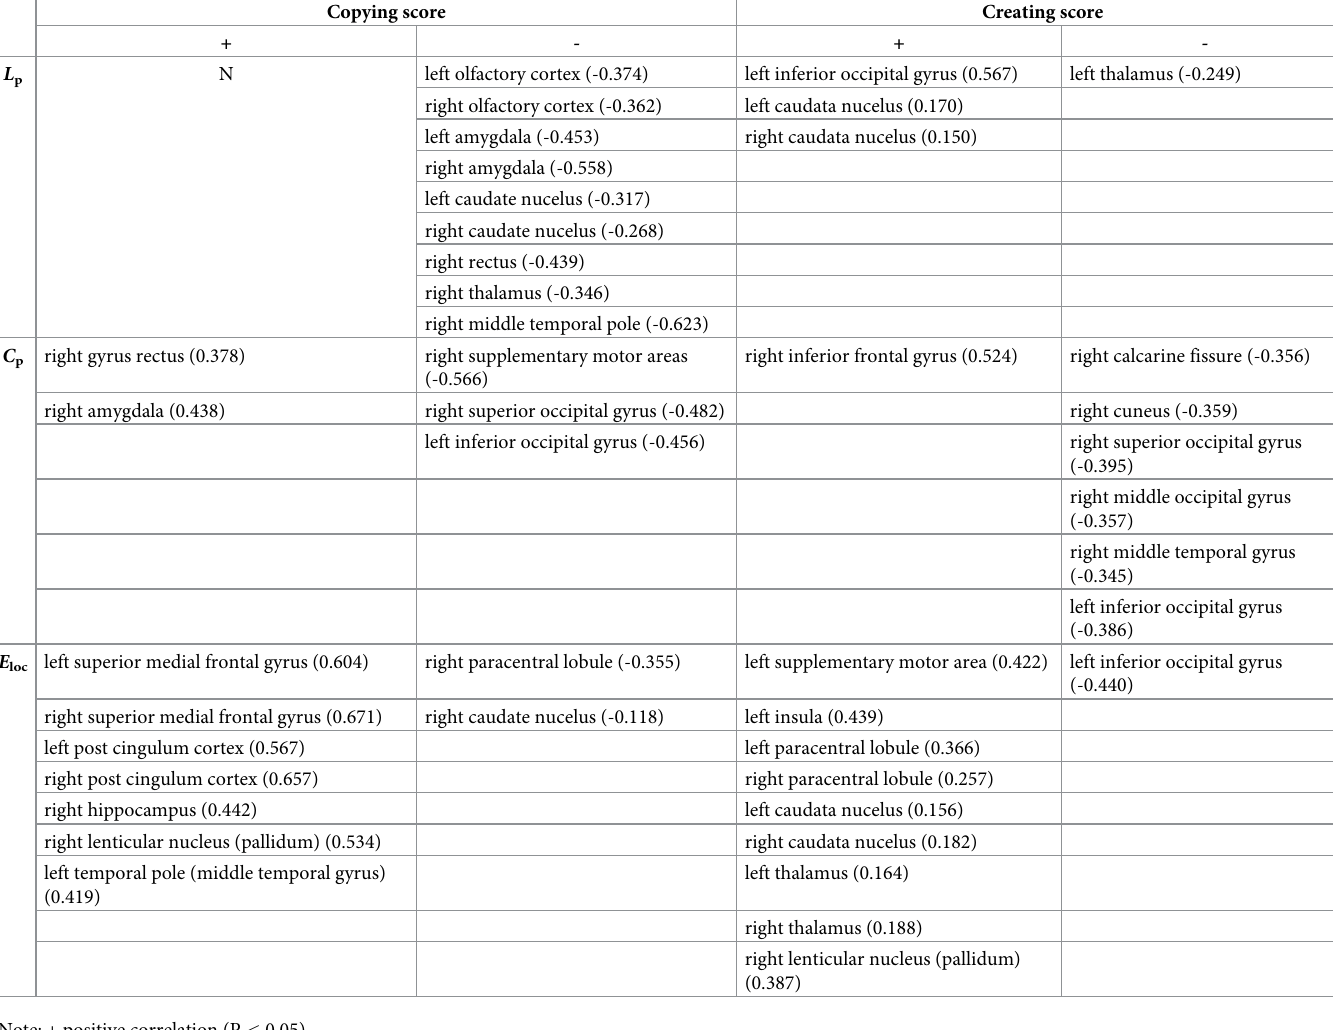
Table 5. The positive (+) and negative (-) correlation brain regions with r values between local topological characteristics (i. e., L p , C p , E loc ) and calligraphy skills. Copying